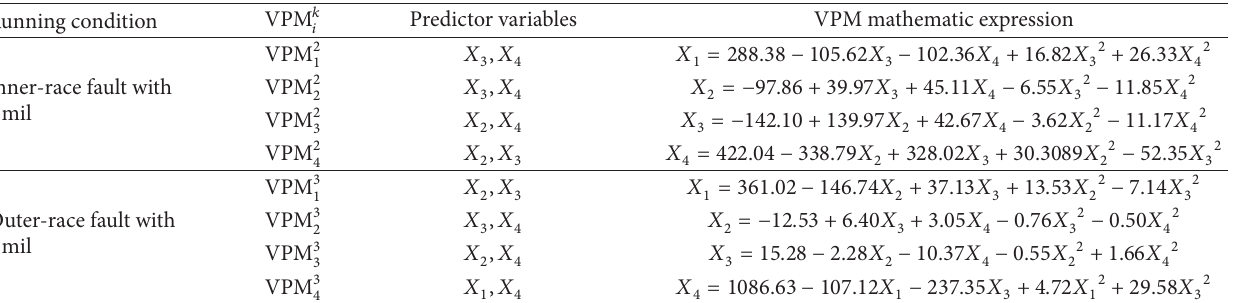
Table 6: The mathematical expression of part VPM 𝑘 𝑖